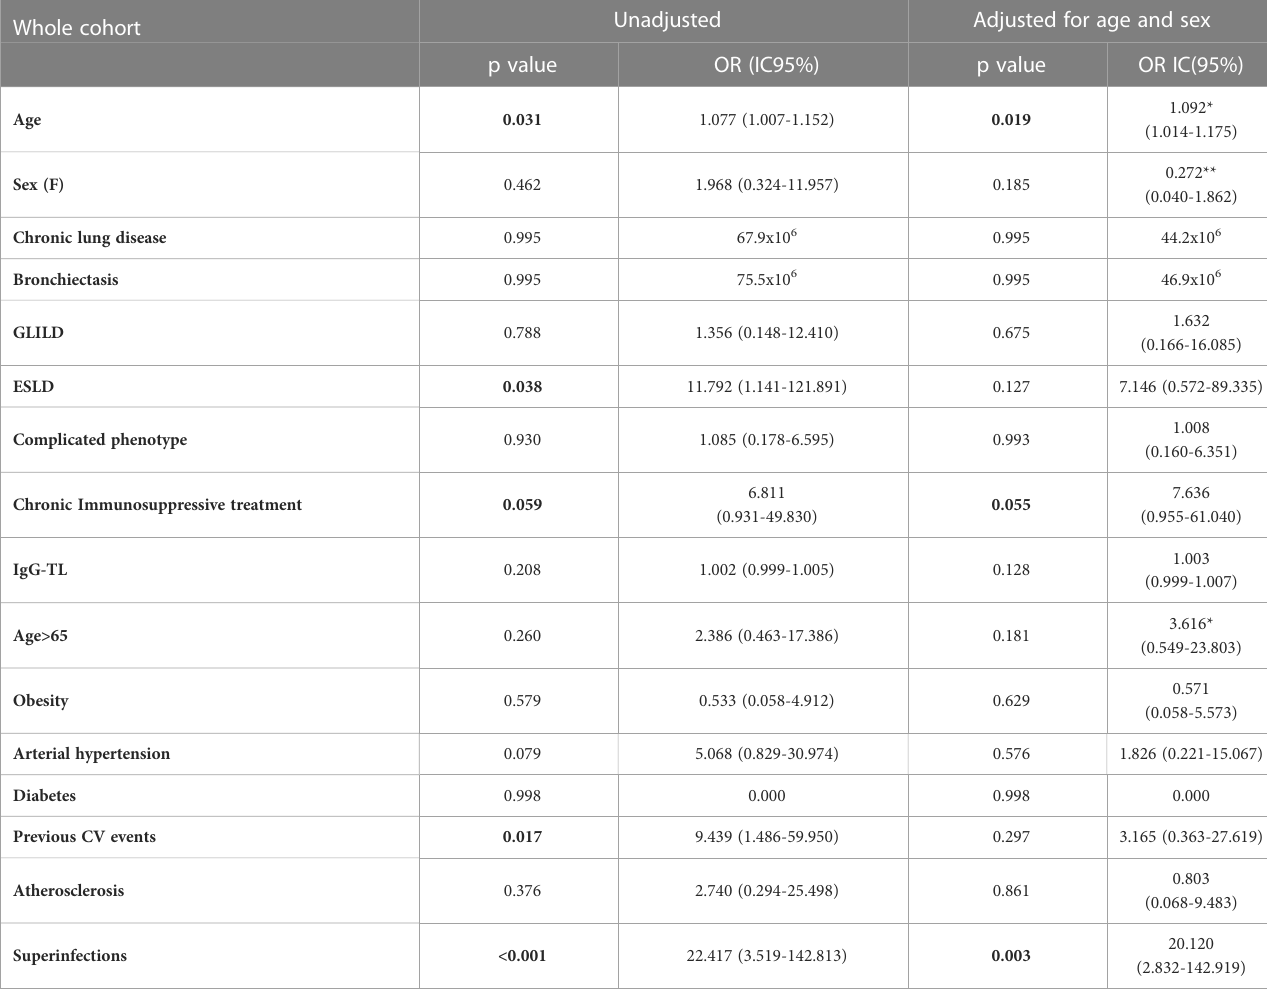
TABLE 6 Univariate logistic regression analysis for mortality in the whole CVID cohort ( waves